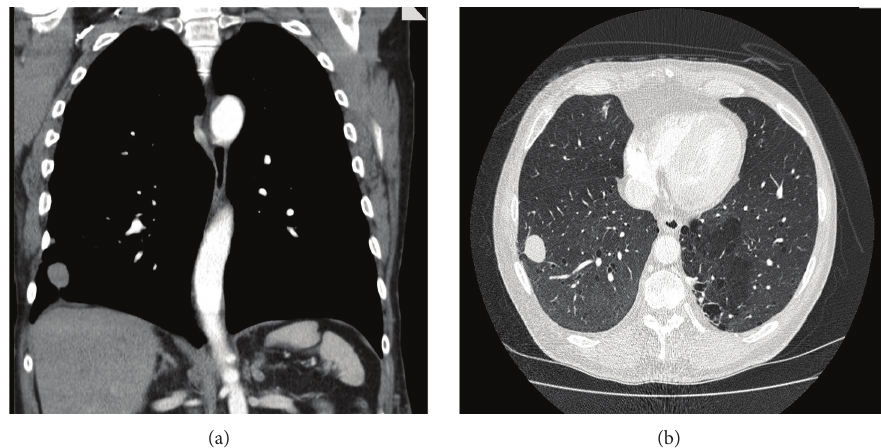
Figure 1: CT imaging of lung metastasis in coronal (a) and axial (b) planes.